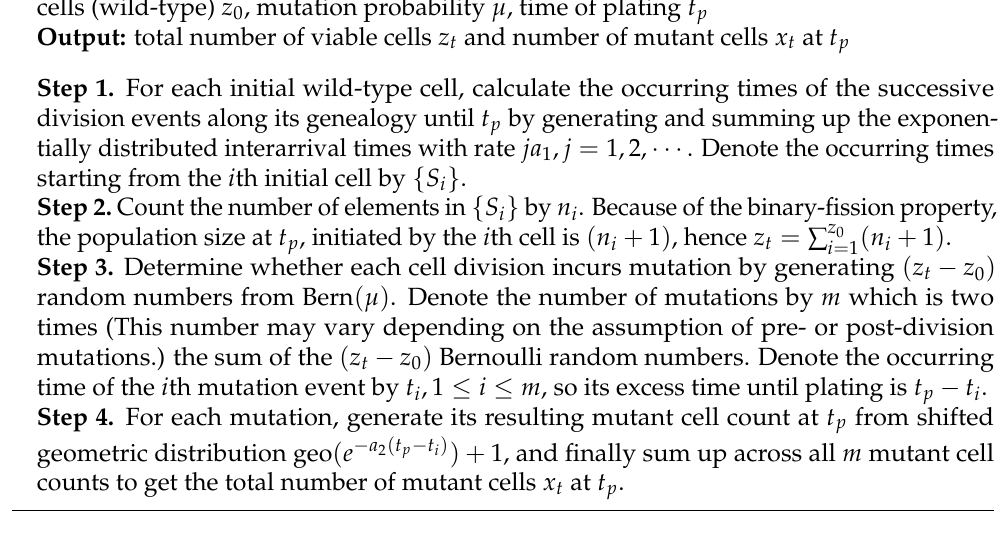
Algorithm 3 Alternative simulator adapted from SALVADOR